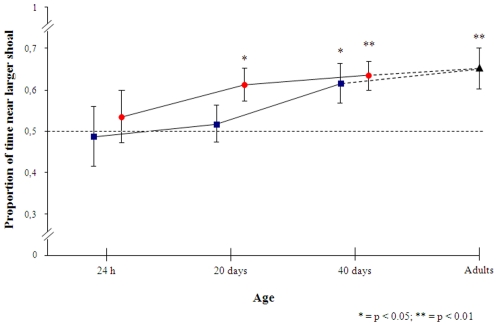
Results of experiment 3.Fish ability to discriminate between 4 and 8 increases in precision over development. Circles with numerical experience in large shoals, squares without numerical experience reared in pairs. The score of 14 adult female guppies (triangle) is also shown for reference (source: manuscript submitted).